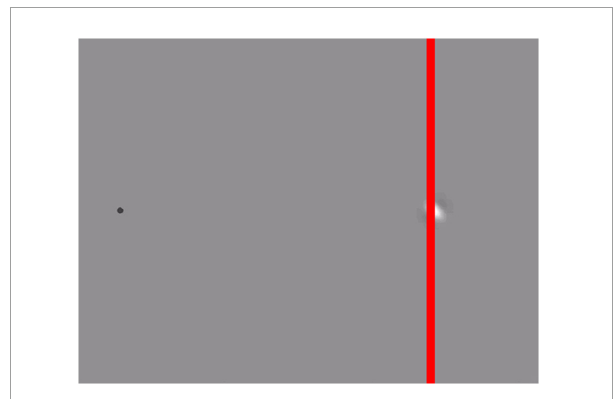
FIGURE3 Inconsistency in the double drift illusion (see Supplementary Video 1 ). When fixating the dot on the left, the Gabor patch appears to move vertically, parallel to the red line. Despite continuing to move vertically, the Gabor appears to cross the red line when it is about halfway along its path. The movie is based on the stimulus used by Lisi and Cavanagh (2015), but with an additional vertical red line that reveals the inconsistency: a change in perceived relative position that is inconsistent with the perceived direction of